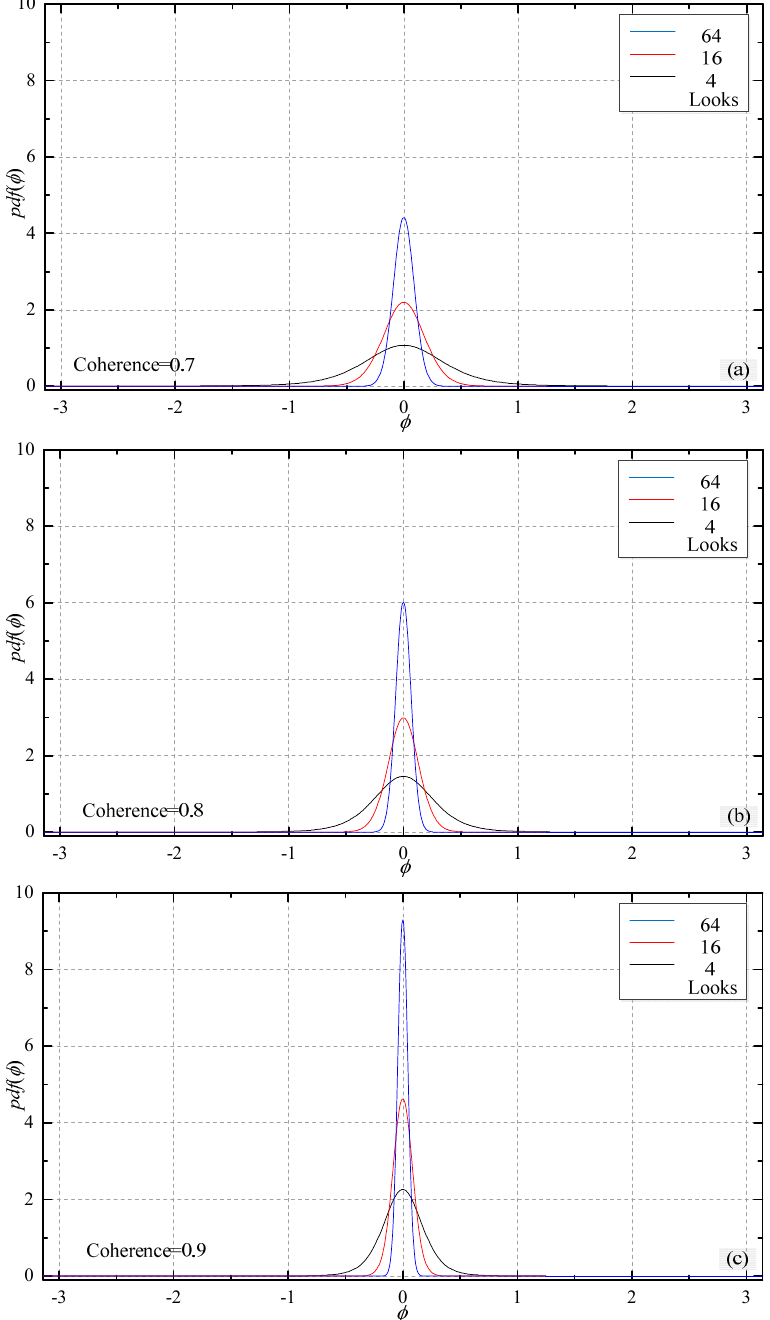
Figure 2. ( a – c ) Noise phase probability density functions with different coherences and number of looks. The coherence is 0.7, 0.8, and 0.9, respectively. The multi-look numbers of the blue, red, and black lines are 64, 16, and 4, respectively.